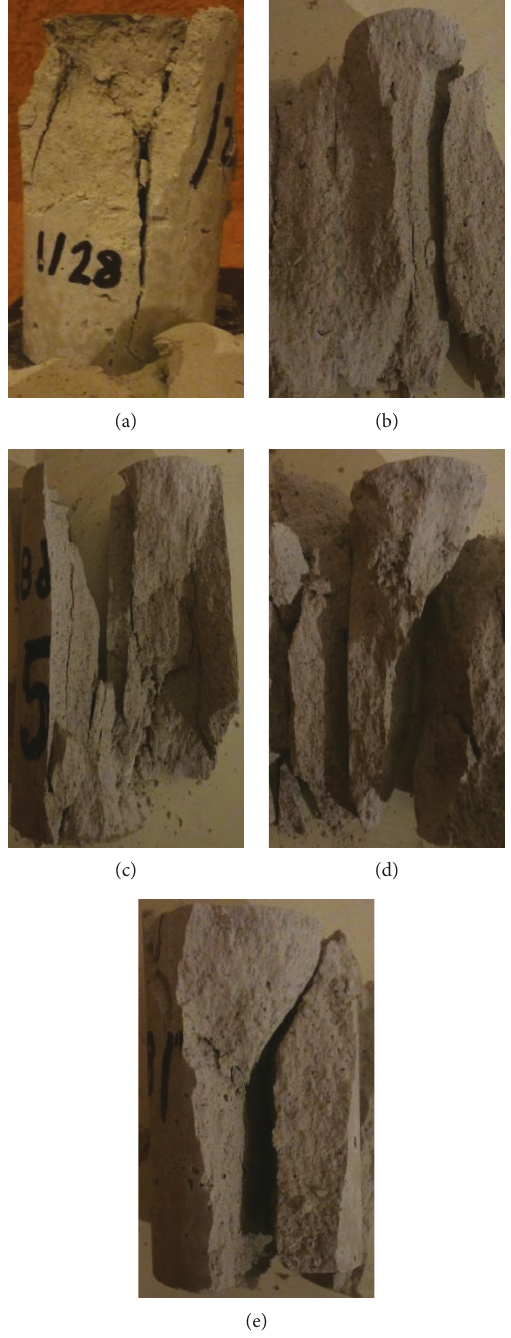
Figure 13: Types of fractures in 28-day samples. Mixtures (a) M1, (b) M3, (c) M5, (d) M7, and (e) M8 with higher performance, respectively, from the left side (own